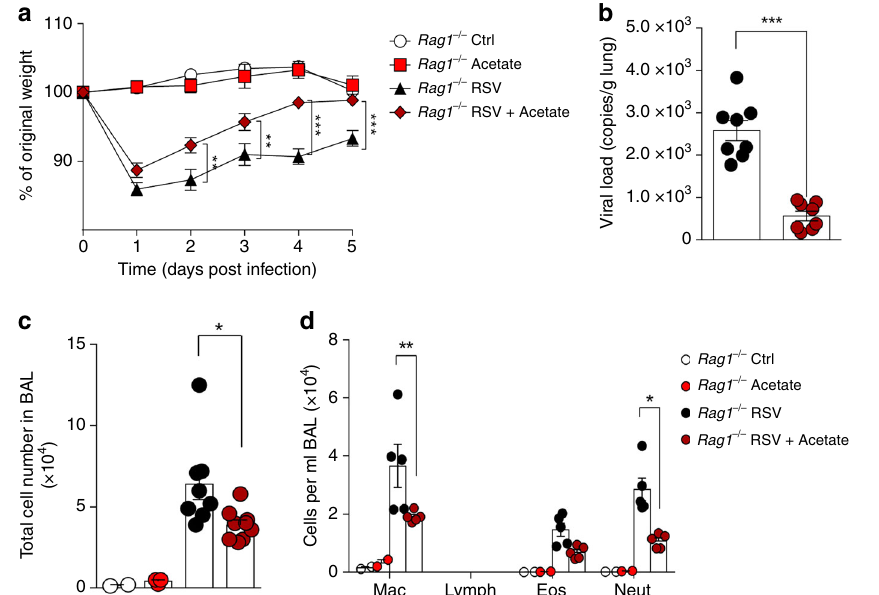
Fig. 5 Acetate treatment protects against RSV infection in the absence of T cells. a – d Female Rag1 knockout mice (background C57BL/6) were simultaneously infected with RSV and treated with 200 mM acetate in drinking water. Analyses were performed on day fi ve post infection. a Percentage body weight loss post infection relative to initial weight (day 0) ( n = 8). Ctrl = untreated and uninfected mice. b RSV viral load detected in lung tissue by real-time PCR (viral copies/g lung tissue) ( n = 8). c Total cell number and d differential cell counts in BALF ( c , n = 8; d , n = 5). All data are expressed as mean ± SEM. Data are from two independent. Statistical signi fi cance between the groups was determined using Kruskal – Wallis test except in b , in which Mann – Whitney was used. * p < 0.05, ** p < 0.01, *** p < 0.001. Data in a – d are provided as a Source Data fi